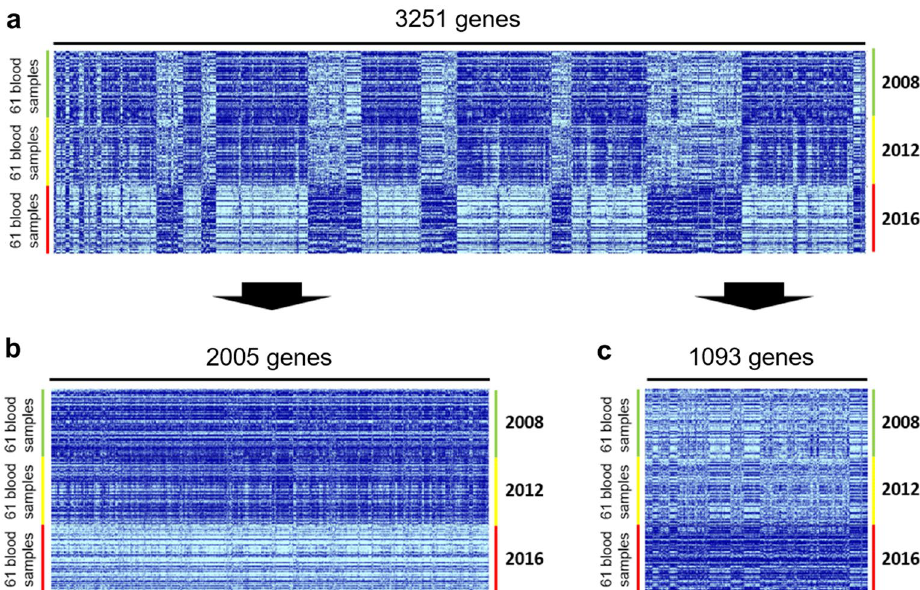
Figure 3. Identification of 3251 differentially expressed genes, followed by stratification of the genes into downregulated (Pattern 1) or upregulated (Pattern 2) genes in the years 2008, 2012, and 2016. ( a ) Heatmap of the 3251 genes with altered expression over the 8-year monitoring period (F-test parametric p -value < 1.0 × 10 –4 , false discovery rate < 1.0 × 10 –3 ). ( b ) Heatmap of the 2005 genes that were downregulated over time; the expression of each gene in 2016 was lower than its expression in 2008 and 2012 (Pattern 1). ( c ) Heatmap of the 1093 genes that were upregulated over time; the expression of each gene in 2016 was higher than its expression in 2008 and 2012 (Pattern